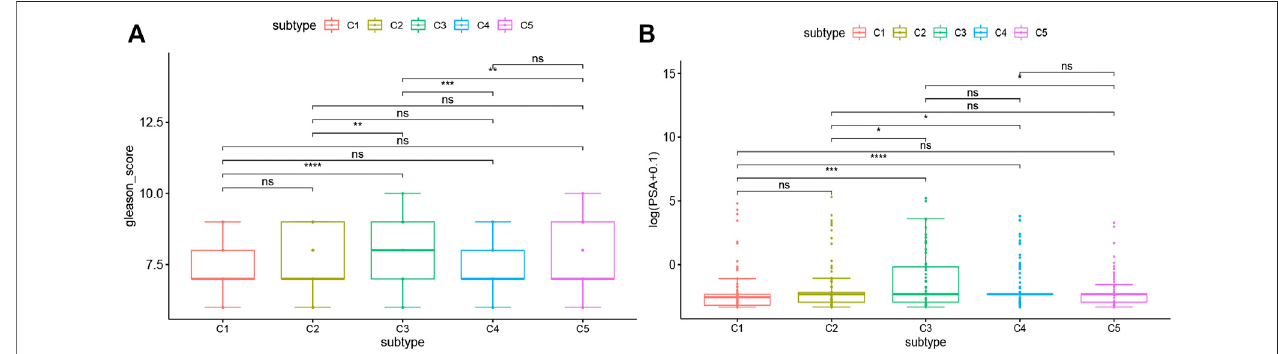
FIGURE 7 | Association between immune subtypes and Gleason score and serum PSA level. (A) Gleason score in PRAD immune subtypes in TCGA cohorts. (B) serum PSA level in PRAD immune subtypes in TCGA